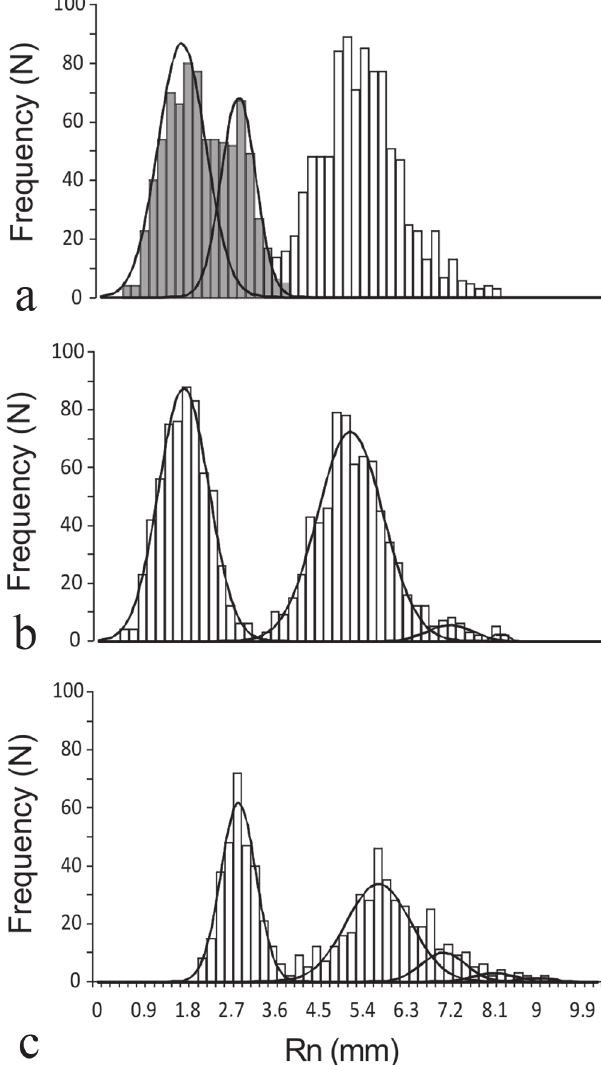
Fig. 4. Total frequency distribution of the scale radius (Rn) and decomposition of first ring measurements (shaded columns) in order to discriminate between the fish from summer and from spring groups ( a ). Decomposition of polymodal frequency distribution of ring measures from summer group ( b ) and spring group ( c